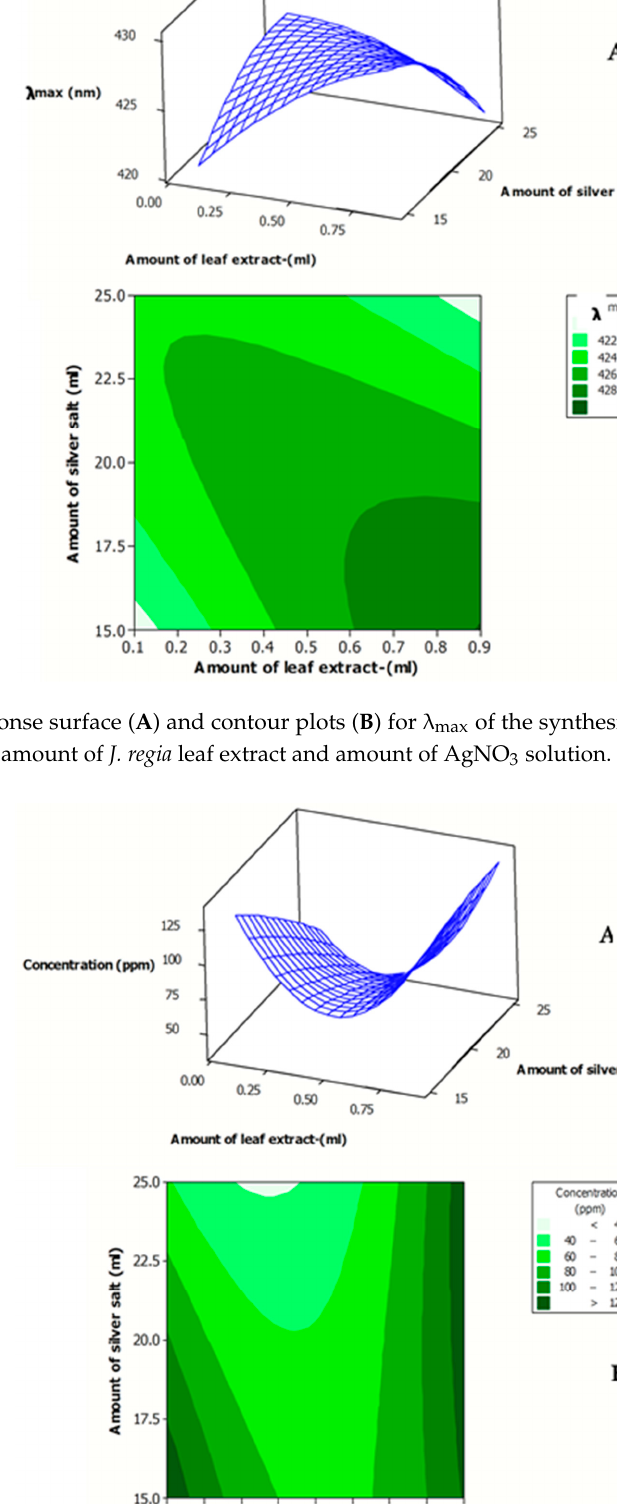
Figure 5. Overlaid contour plot of Ag NPs λ max and concentration with acceptable levels as a function of amount of J. regia leaf extract and amount of AgNO 3 solution.